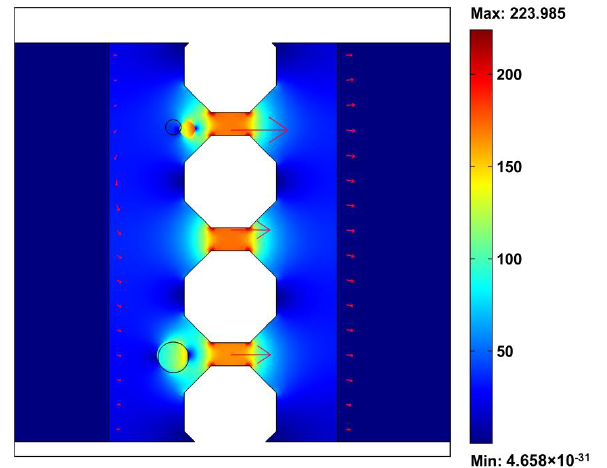
Figure 3. Distribution of the electric field and the movement of different size particles on a microfilter and negative dielectrophoresis combined chip. Arrows represent the direction of the flow field.